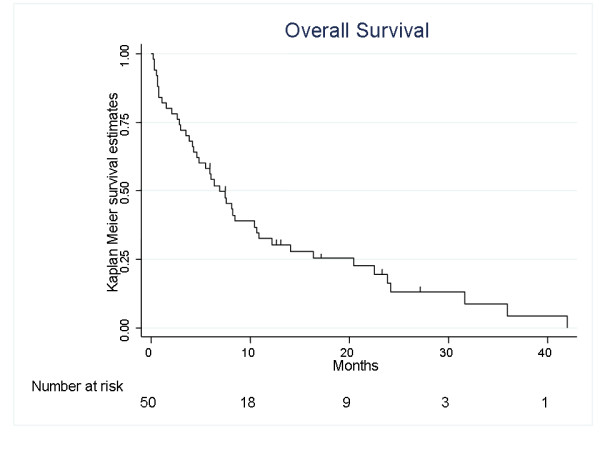
Overall Survival